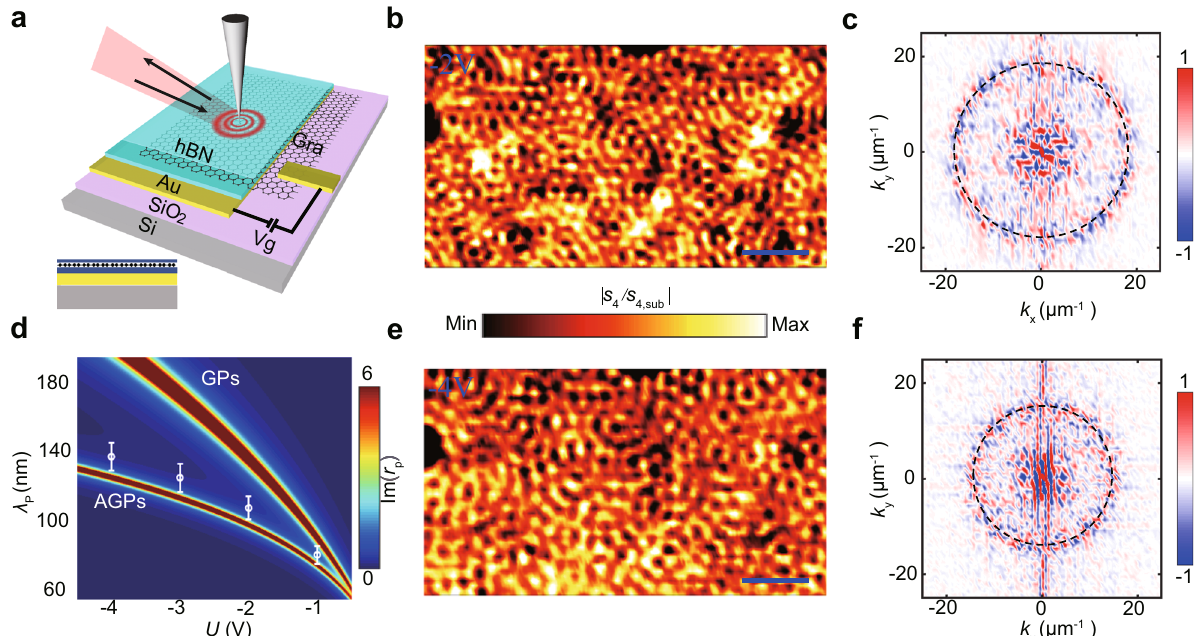
Fig. 1 Structure and the near- fi eld response of an acoustic graphene plasmon (AGP) device. a Schematic of the AGP device, which is composed of h-BN (2 nm)/graphene/h-BN (6 nm) heterostructure placed on Au (50 nm)/SiO 2 (300 nm)/Si substrate. The inset shows the cross-section view of the AGP device. b Real space near- fi eld image of the AGPs at − 2 V, the color bar represents the normalized intensity. c The amplitude of the Fourier transformation of ( b ) in momentum space ( k x , k y ). d The comparison between the wavelength and back gate voltage-dependent dispersion of AGPs and that of graphene plasmons (GPs). The dispersion was obtained by caculating the imaginary of the re fl ection coef fi cient (Im( r p )) with the transfer matrix method. The white circles represent the experimental results. The error bars show the width of the concentric circles in momentum space. e , f Near- fi eld image of the AGPs at − 4 V and the corresponding Fourier transform. The wavelength of excitation light is λ = 10.653 μ m. Scale bars, 300 nm.